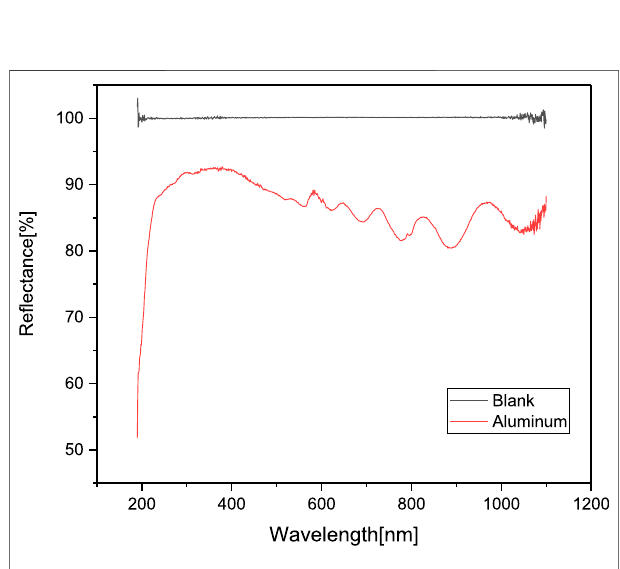
FIGURE 4 | Re fl ectance of the aluminum coating